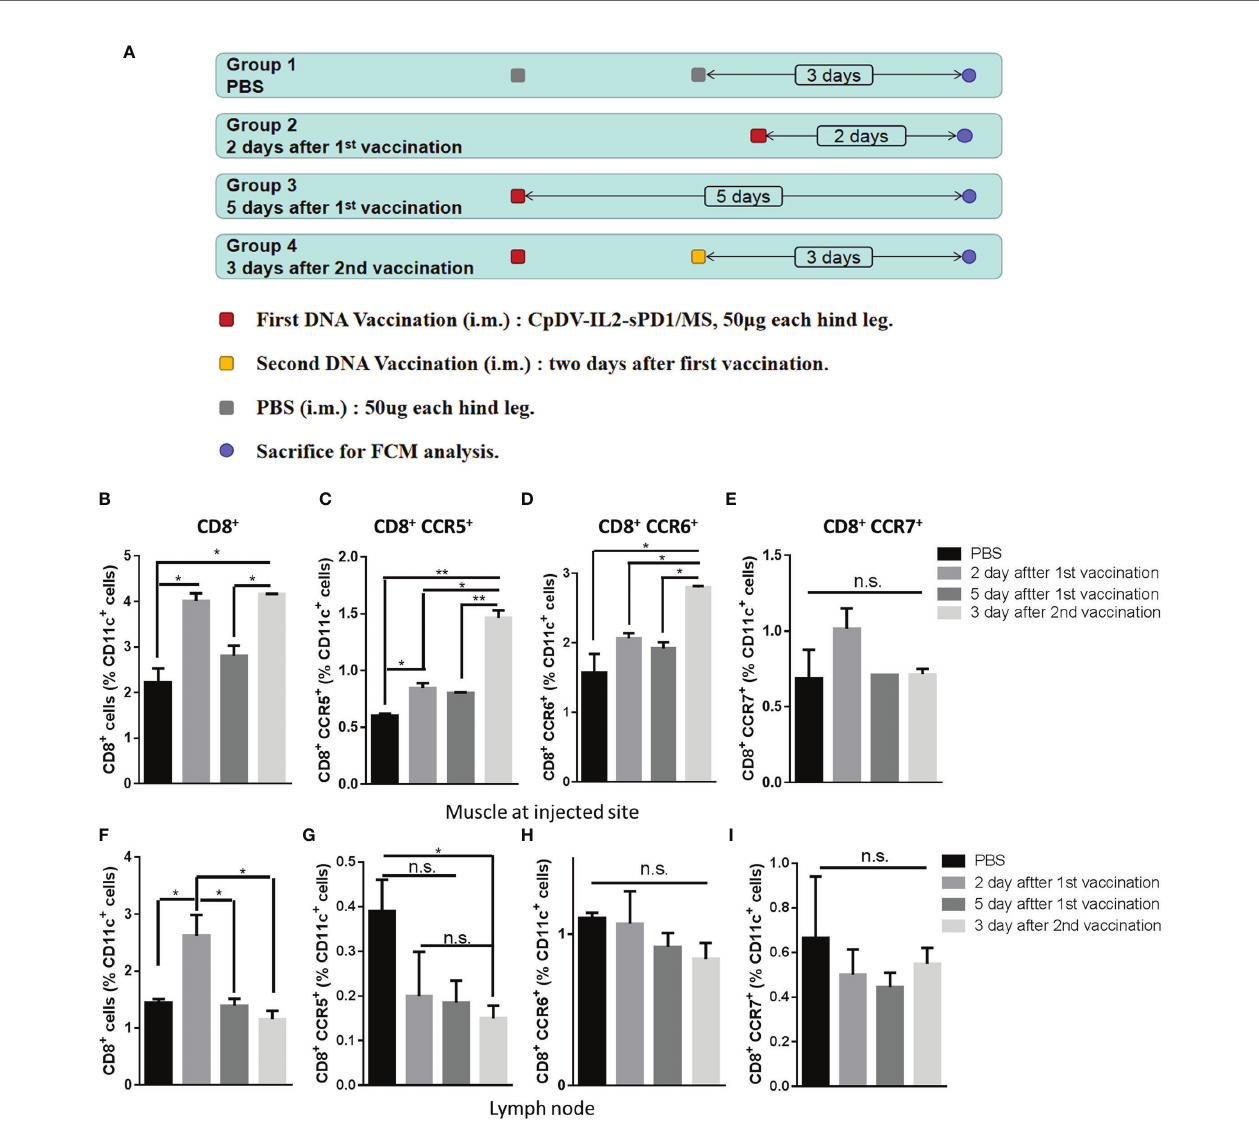
FIGURE 2 | Timeline of CD11c + antigen-presenting cell (APC) migration to the injection site and homing to ipsilateral inguinal lymph nodes. (A) Four groups of BALB/c mice (three mice in each group) were vaccinated as indicated, and 100 m g CpDV-IL2-sPD1/MS was injected intramuscularly at each time point. All mice were sacri fi ced on the same day. CD11c + cells were isolated and analyzed via fl ow cytometry. Percentages of CD8 + , CD8 + /CCR5 + , CD8 + /CCR6 + , and CD8 + /CCR7 + subsets among CD11c + cells isolated and enriched from muscle cells (B – E) and lymph nodes (F – I) . (* p < 0.05, ** p < 0.01, n.s., p >